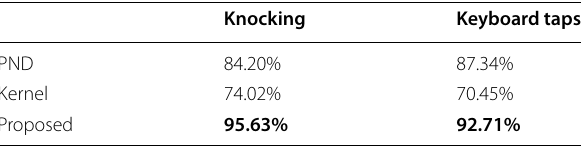
Table 2 The accuracy of voice activity detection of three algorithms in two transient